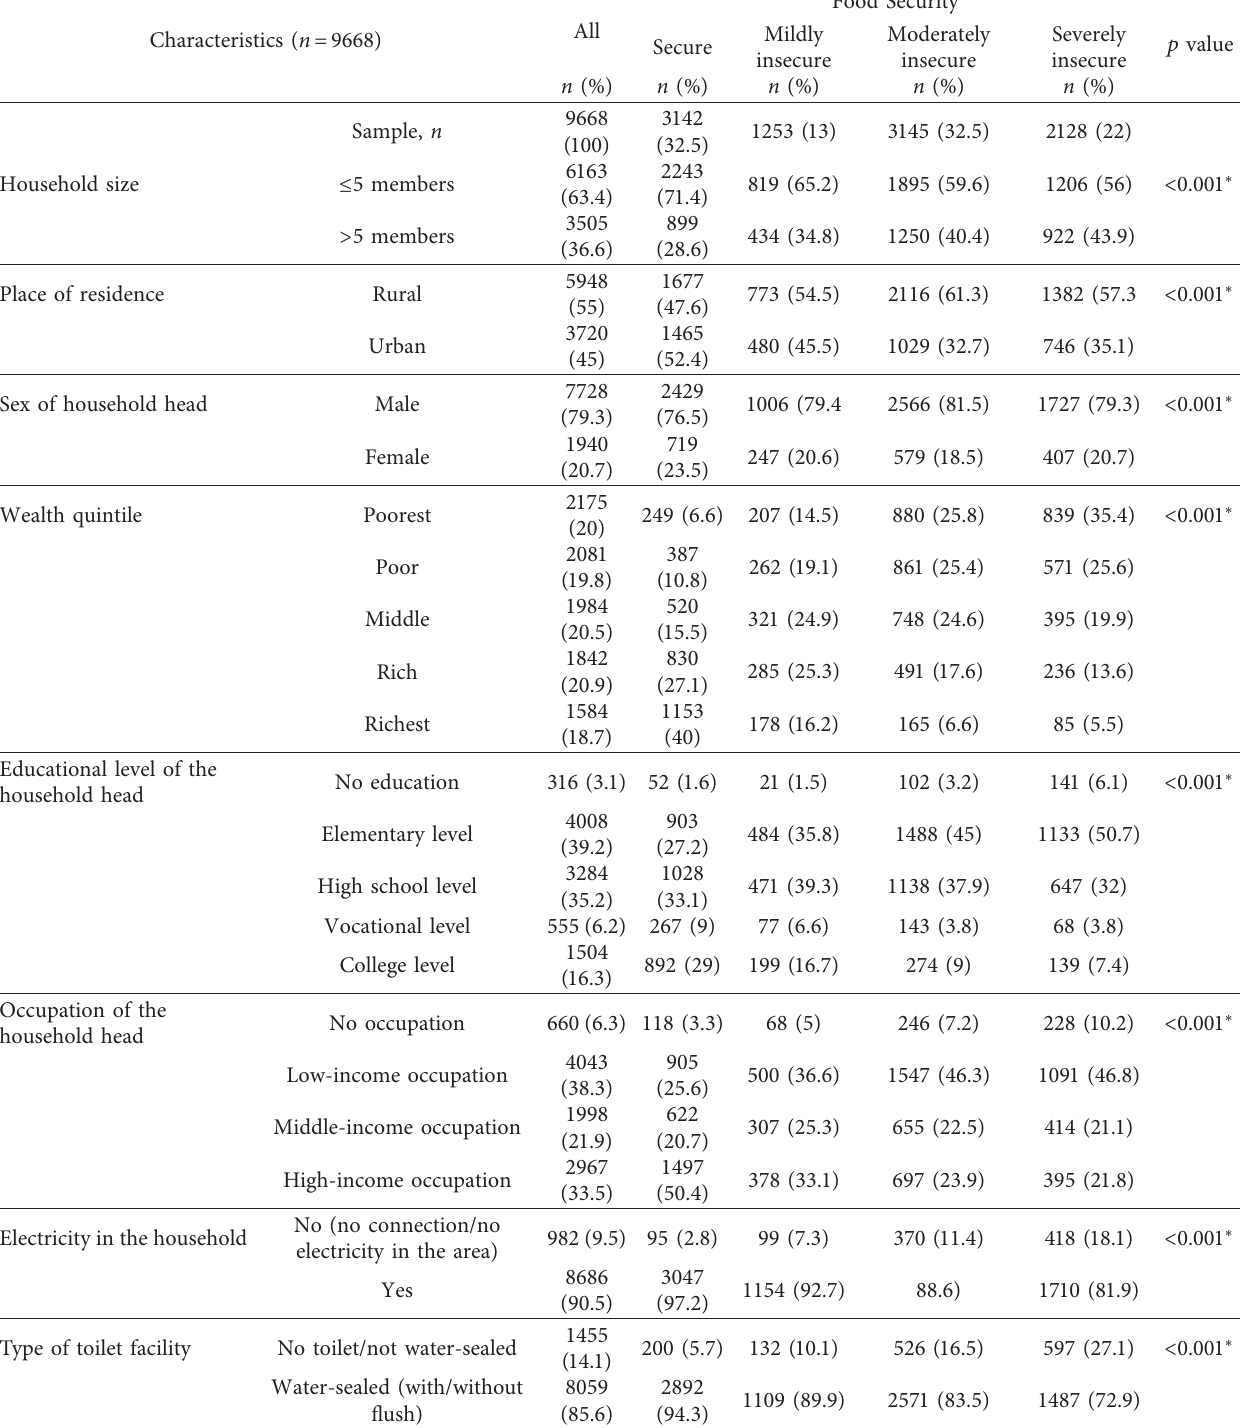
Table 5: Household